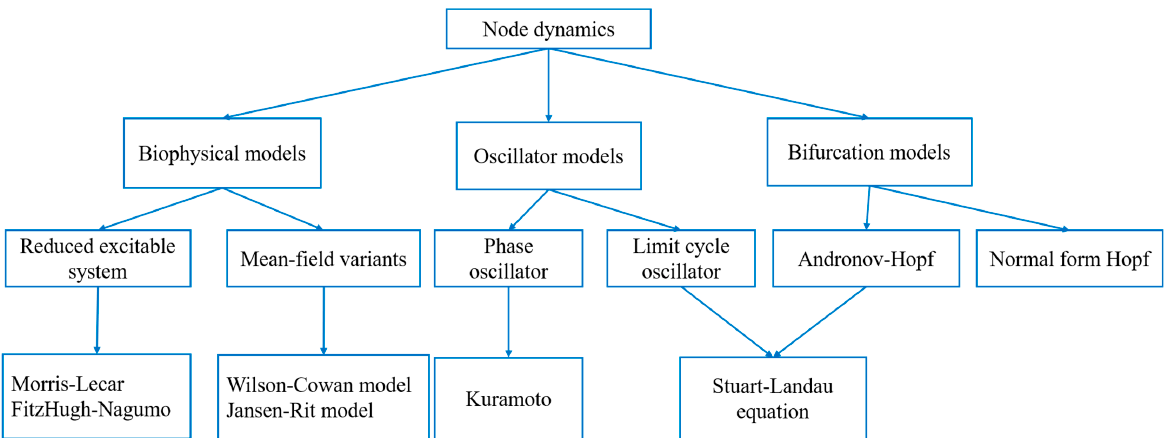
Figure 1. According to the level of detail and neurophysiological relevance, models of node dynamics can be divided into biophysical models, oscillator models, and bifurcation models. The mean-filed models and Kuramoto oscillators are the most commonly used models of node dynamics.